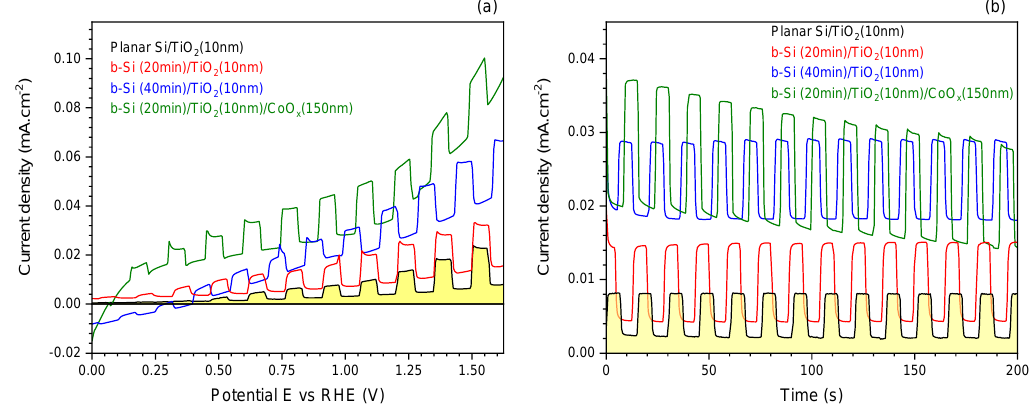
Figure 6. SEM images of as-fabricated b-Si photoanodes etched for 20 min and coated with 10 nm TiO 2 with addition of 150 nm CoO x cocatalyst.